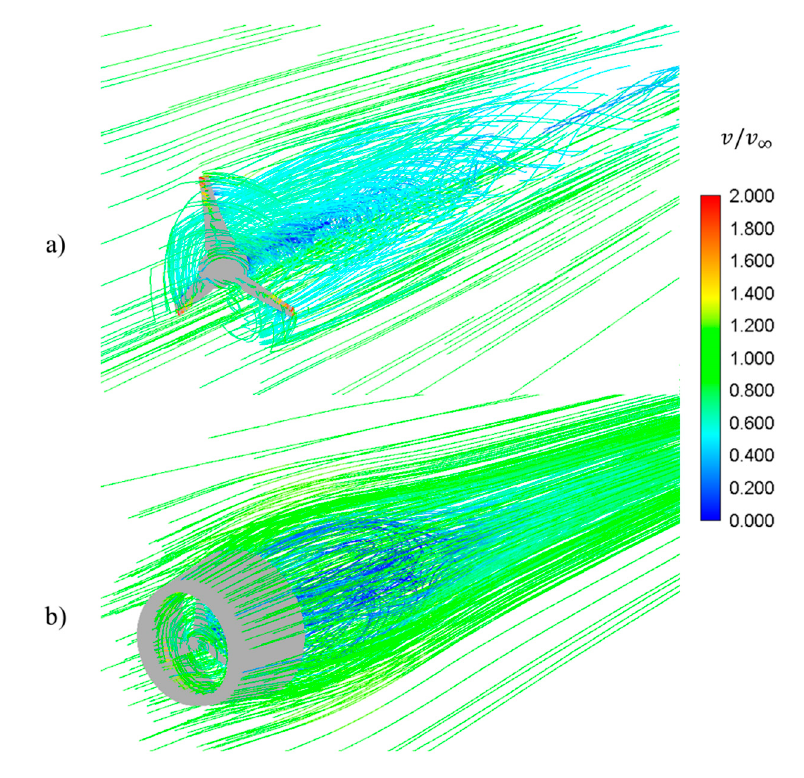
Figure 12. Normalized velocity, 3D streamlines, comparison between: ( a ) Bare turbine; ( b ) Diffuser- augmented DFN-3 turbine.